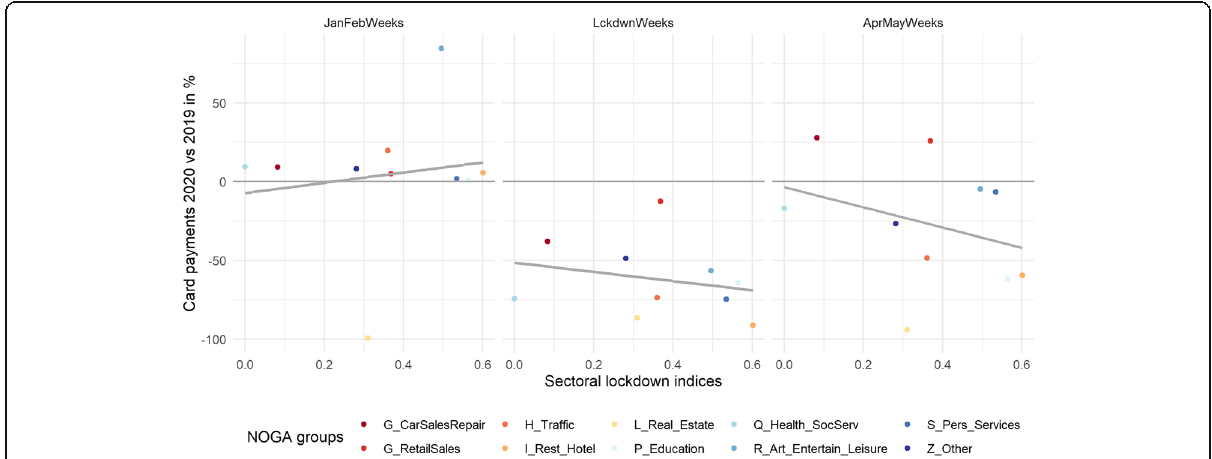
Fig. 3 Excess card payments in percent by the NOGA-2 groups versus corresponding “ sectoral lockdown indices ” for pre-lockdown (left), lockdown (middle), and post-lockdown (right) periods. Source: Own calculations, Worldline/SPS,